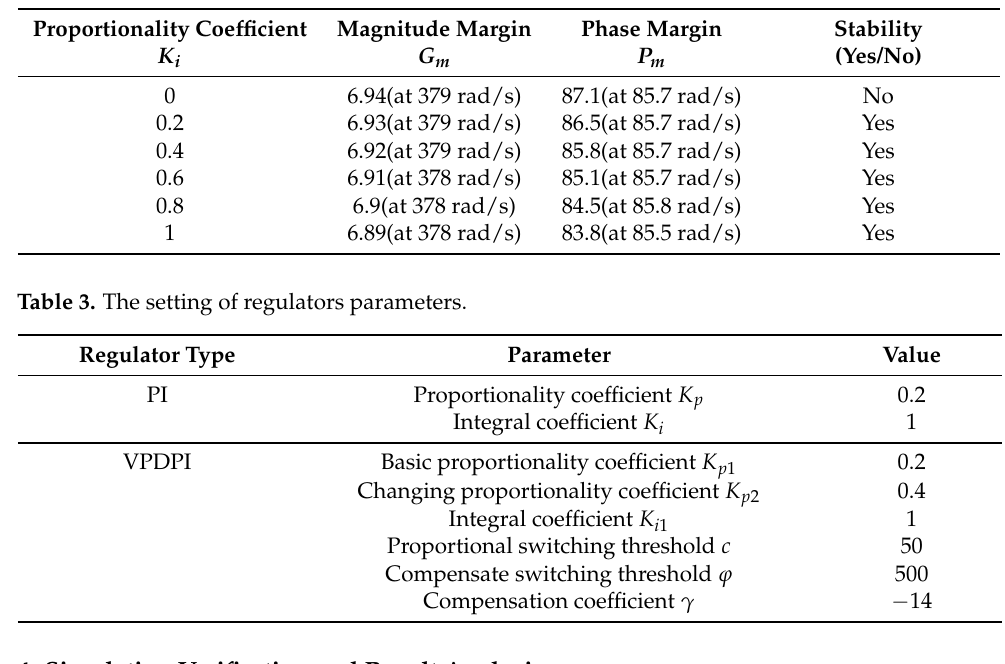
Table 2. The characteristics with different integral coefficients.